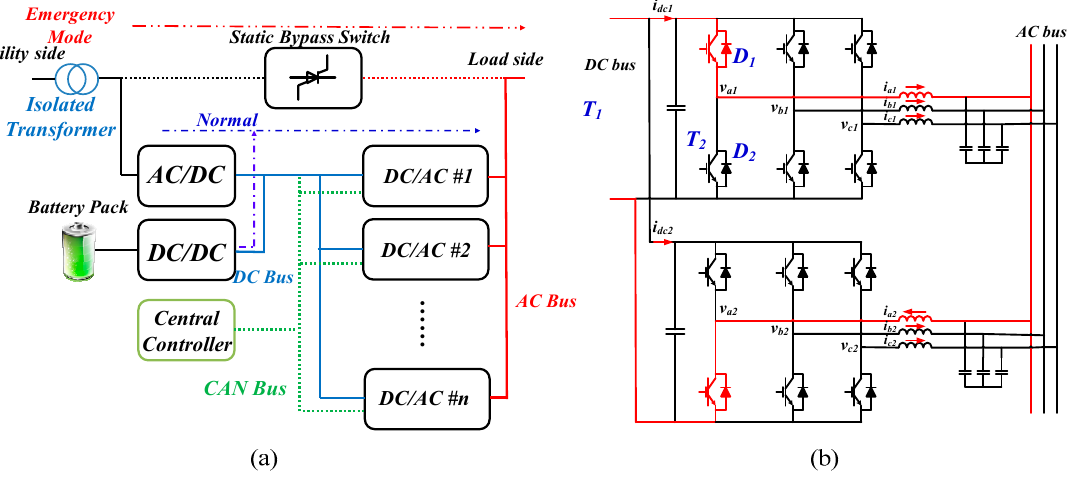
Figure 1. Modular uninterruptible power supplies (UPSs) system architecture and circulating current path: ( a ) modular UPS system structure; and ( b ) circulating current flowing path.